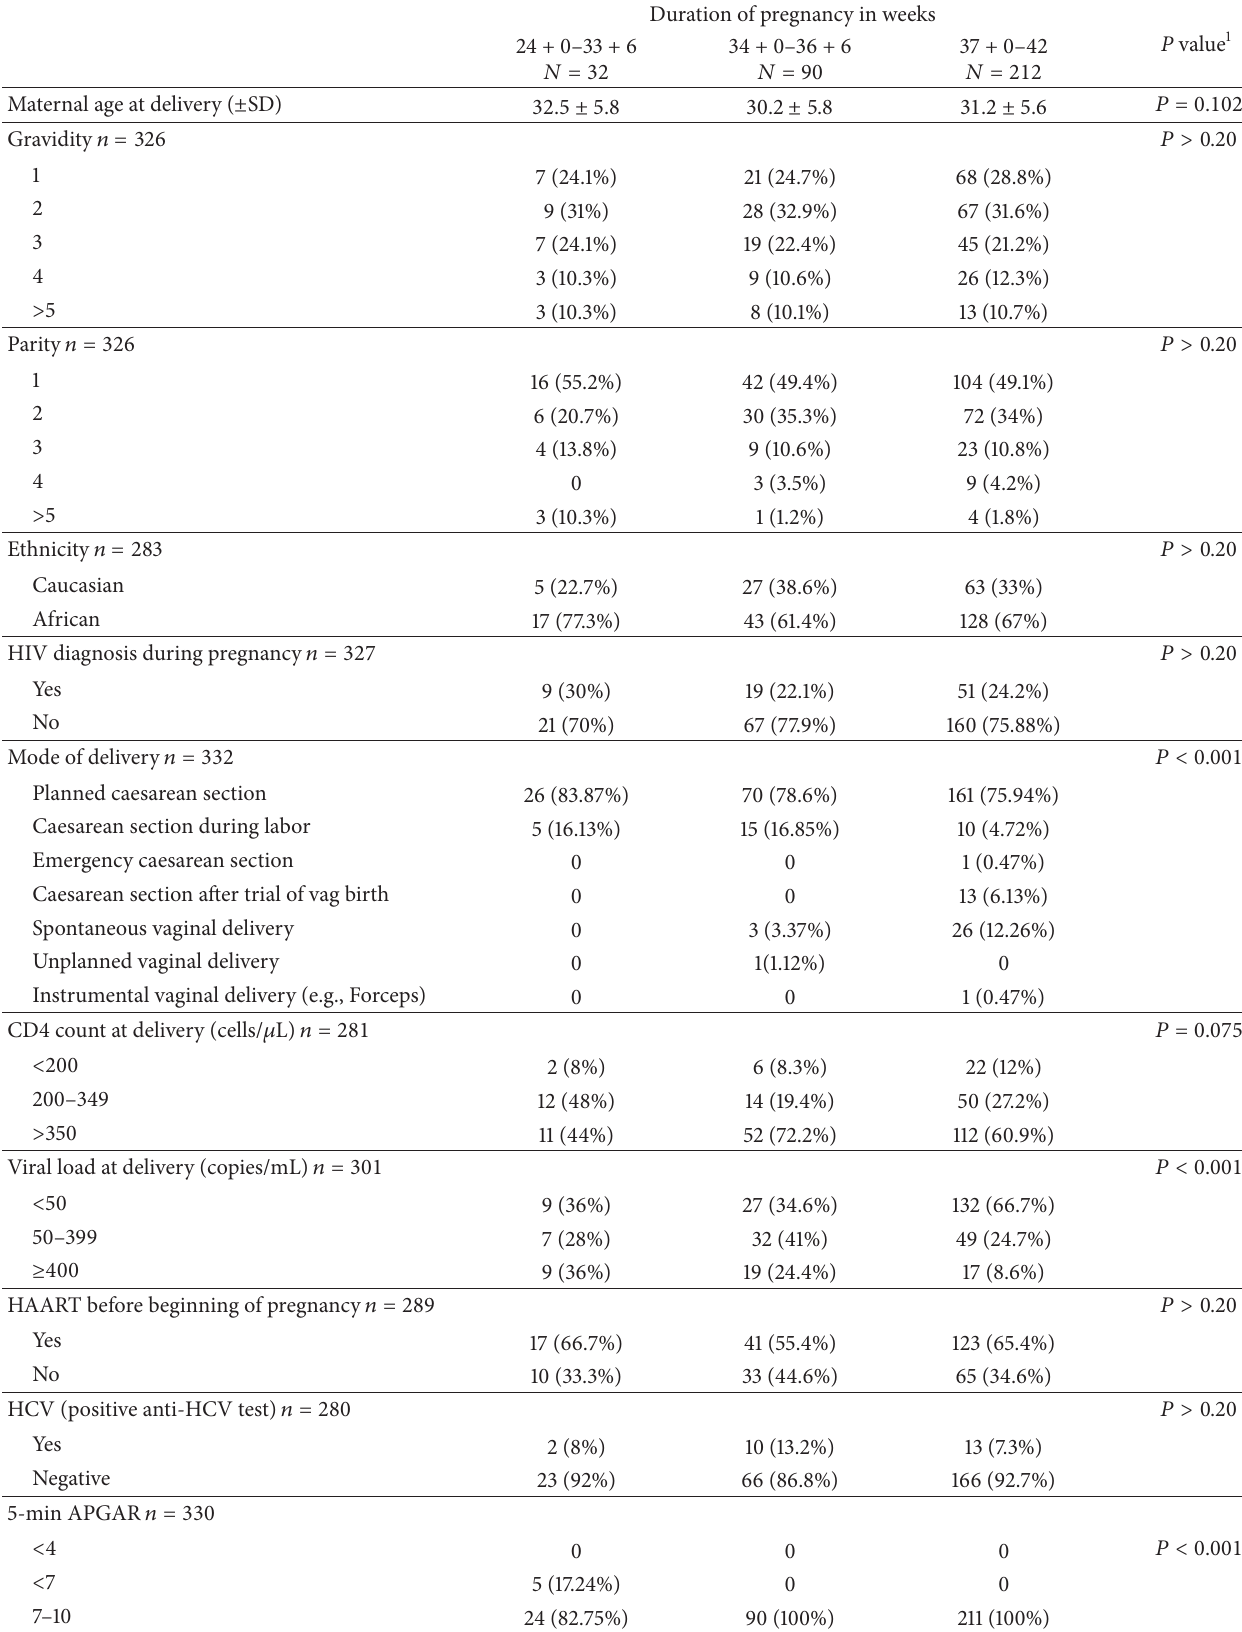
Table 2: Maternal and neonatal characteristics according to duration of